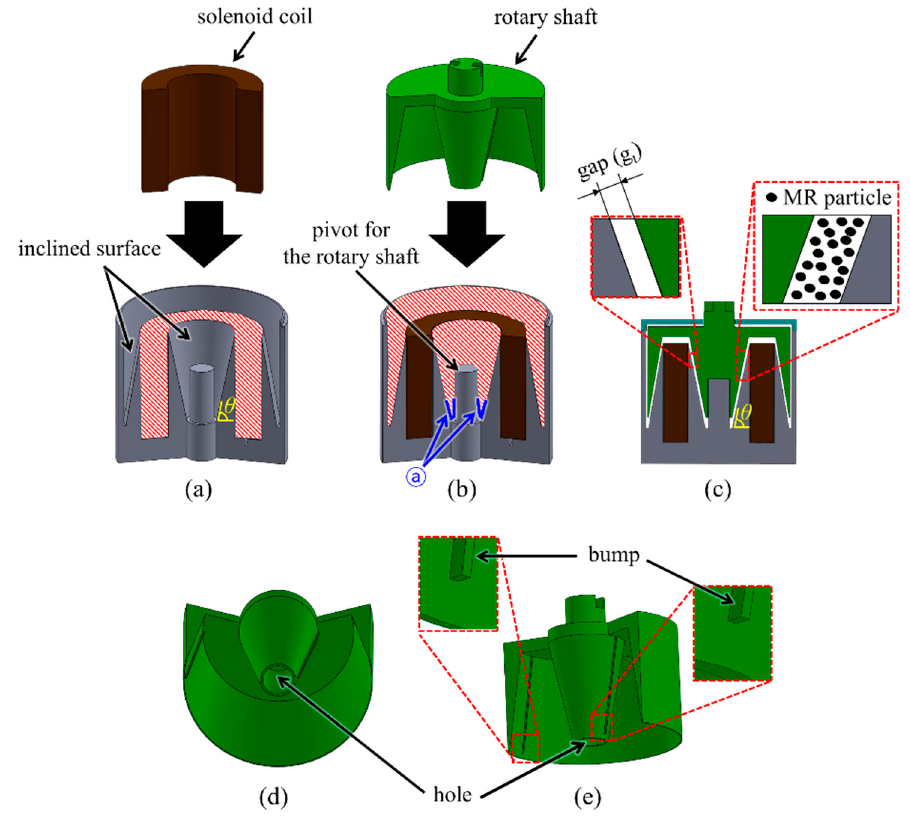
Figure 2. Detailed structure of the housing and the rotary shaft, and the combined process with the solenoid coil: ( a ) Process for combining the housing and the solenoid coil; ( b ) process for combining the rotary shaft and the housing; ( c ) cross-sectional view of the housing equipped with the solenoid coil, rotary shaft, and housing cover; ( d ) bottom view of the rotary shaft; ( e ) long and slender bumps on the surface of the rotary shaft.